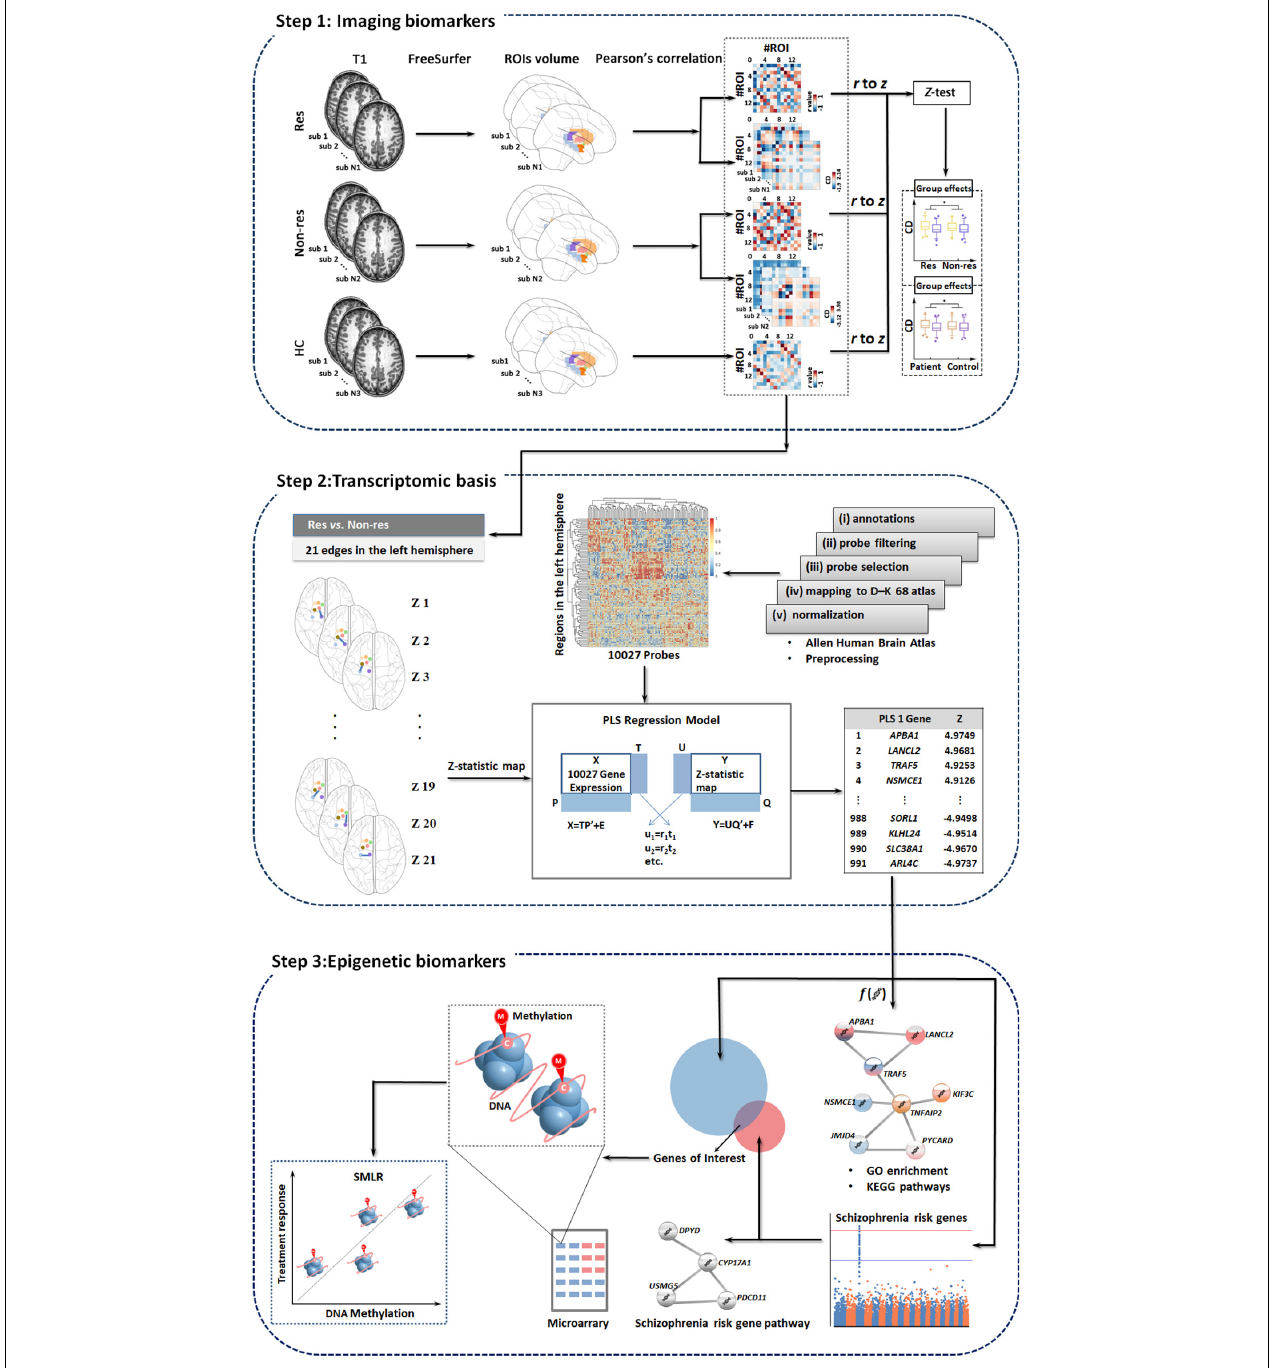
FIGURE 1 | Study overview. We develop baseline biomarkers associated with treatment outcomes using multi-omic measures linking subcortical covariant network, transcriptomic signatures, and peripheral epigenetic modifications based on three steps. Res, responders; Non-res, non-responders; HC, healthy controls; PLS, partial least squares; GO, gene ontology; KEGG, Kyoto encyclopedia of genes and genomes; SMLR, stepwise multiple linear